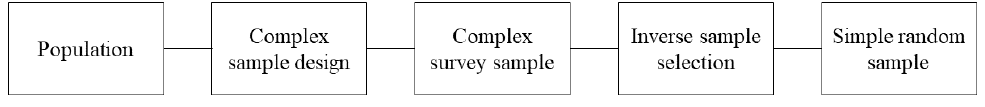
Figure 1. Scheme of the inverse sampling algorithm. Source: